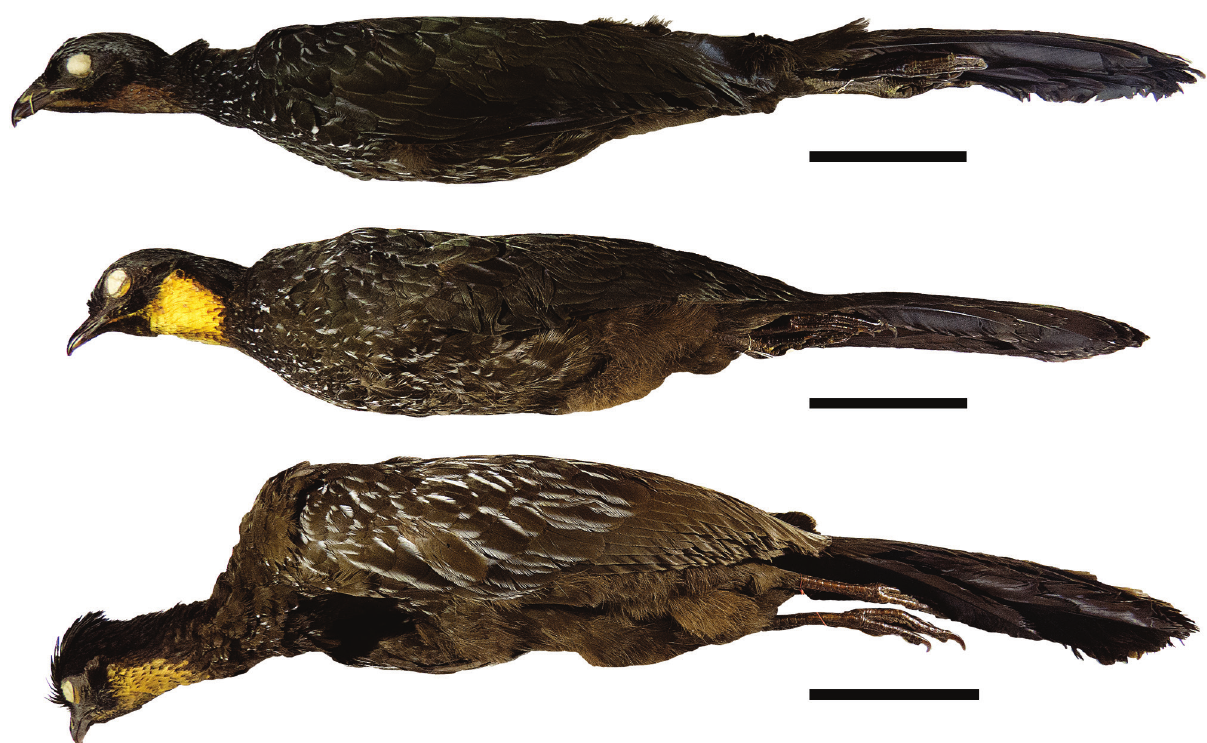
Figure 5. From top to bottom: lateral view of P. o. bronzina (MZUSP 49384, São Paulo, southeastern BR), P. o. obscura (MACN 48384, Corrientes, northeastern ARG), and P. o. bridgesi (MACN 8148a, Tucumán, northern ARG). Scale bars: